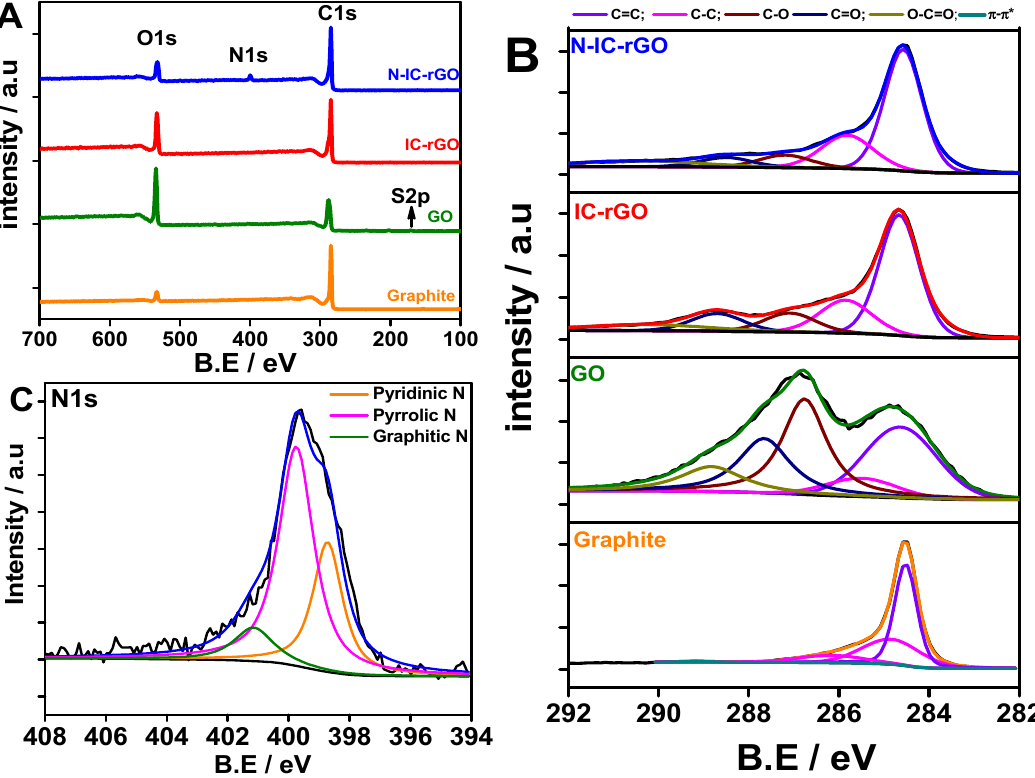
Figure 4. ( A ) XPS survey spectra of graphite, GO, IC-rGO, and N-IC-rGO. ( B ) High-resolution (HR) C1s spectra of graphite, GO, IC-rGO, and N-IC-rGO. ( C ) High-resolution N1s spectra of N-IC-rGO. (adapted from ref. [78,81], with permission from Royal Society of Chemistryand Elsevier, 2017 and 2020).